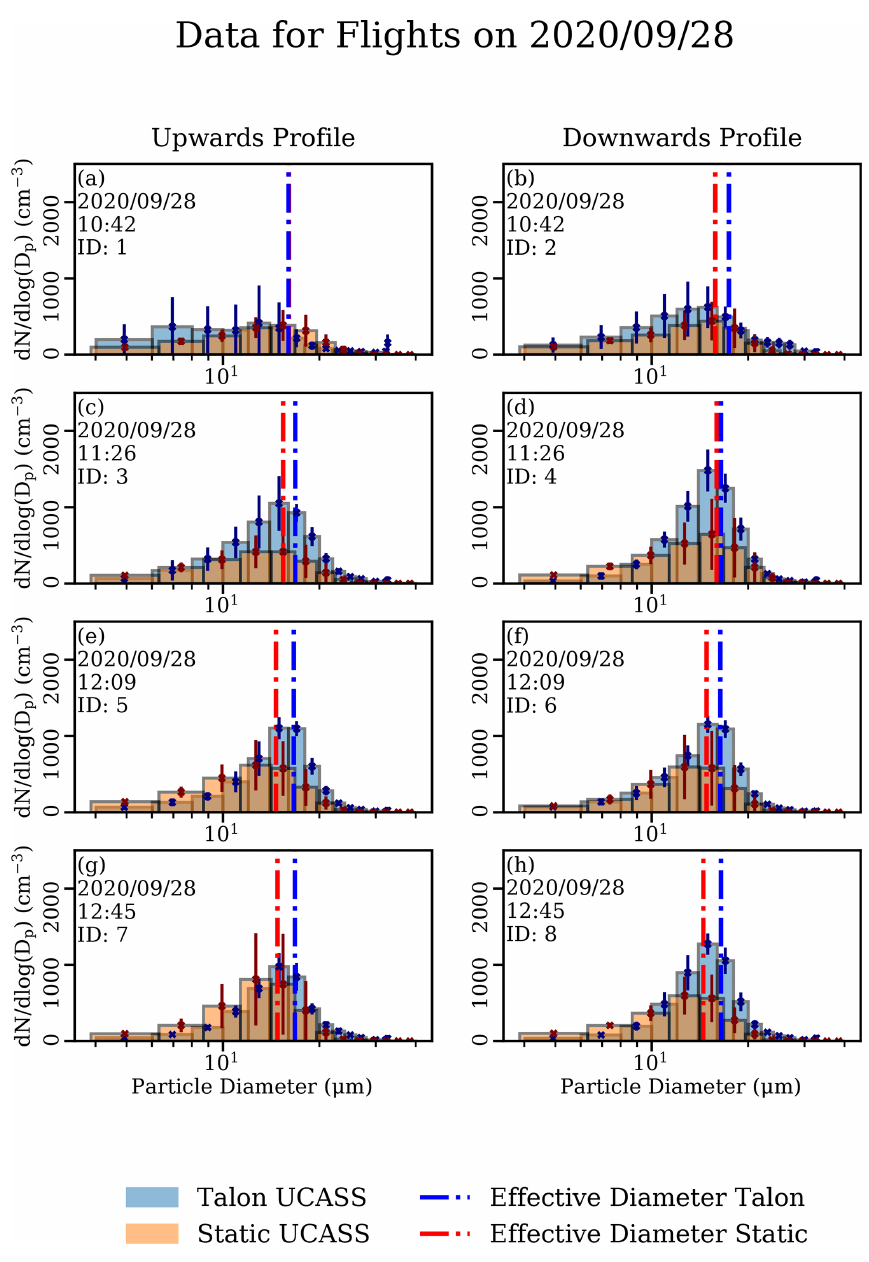
Figure 11. Plots of d N/ dlog (D p ) plotted against droplet diameter for the FMI-Talon–UCASS combination coincident with Sammaltunturi station, for the flights conducted on 29 September 2020. The legend and axes are consistent with Fig. 10. The profile ID stated is consistent with Table